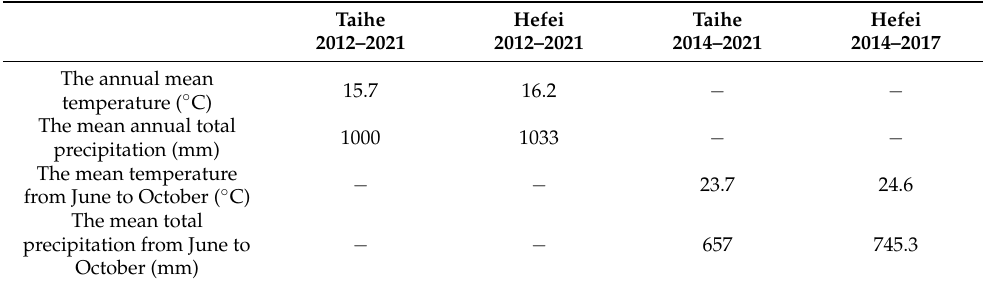
Table 2. The meteorological data details at Taihe and